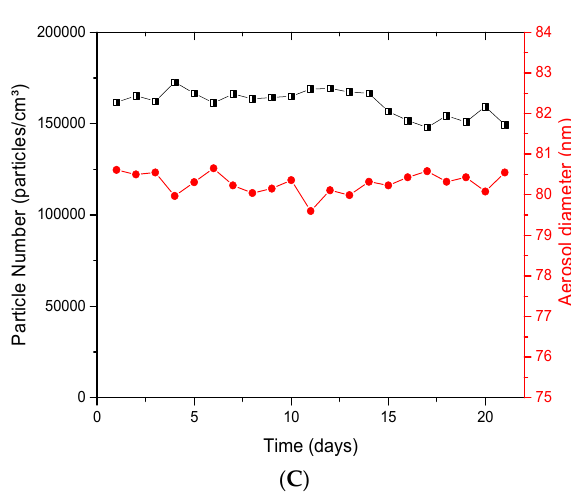
Figure 2. Evaluation of aerosols generated with the collision jet generator: ( A ) size distribution of typical titanium dioxide (TiO 2 ) aerosols as function of mass concentration; ( B ) stability of aerosols during 8 h; ( C ) long ‐ term stability of the number of particles and diameter in the aerosols over 21 days. The TiO 2 (20 nm) suspension concentrations used were: in ( A ), 0, 1 and 10 mg/mL with an airflow rate of 5 L/min; in ( B ), 5 mg/mL with 3.5, 5 and 7 L/min; in ( C ), 5 mg/mL with 5 L/min to generate an aerosol per day during 21 days. The red points represent diameters of particles in the aerosol (nm) monitored at specific time points over 21 days (see right ordinal axis).